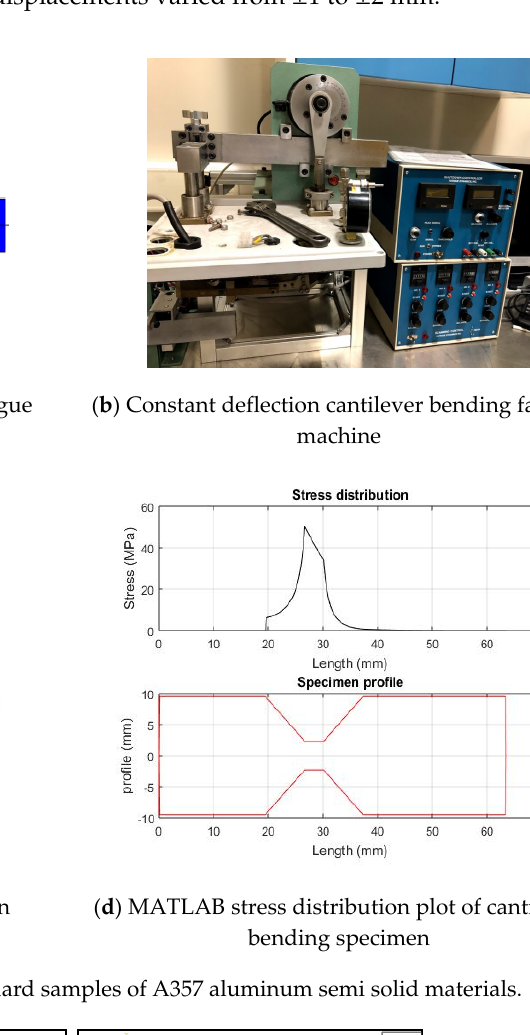
Figure 1. Accelerating thermal aging cycles; ( A ) T6/T7 a ging, ( B ) T7/T6 aging, ( C ) multiple thermal aging cycles.